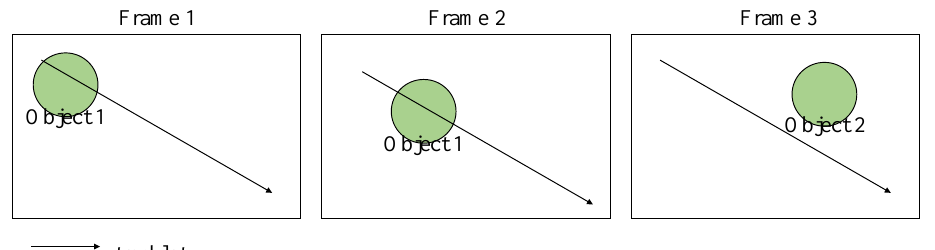
Figure 7. Example of the ID switch problem. The object in frame 1 and the object in frame 2 are considered to have the same id because they are in the tracklet. On the other hand, frame 3 is judged to contain a different object because, there, the object is outside of the tracklet, and thus a new id is